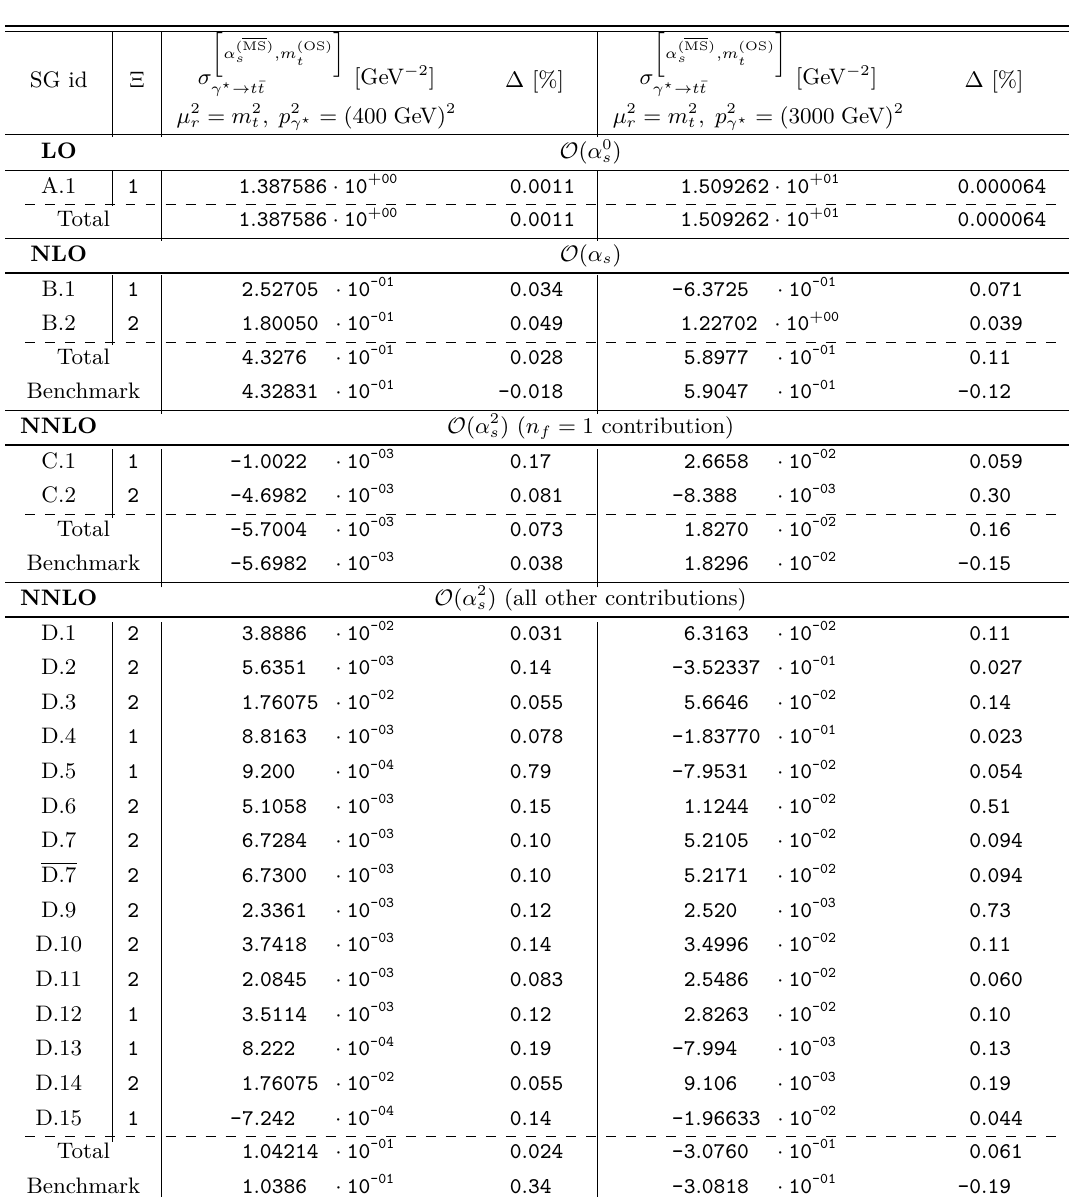
Table 3. Contributions from individual supergraphs listed in table 12 to the cross-section up to order O ( α 2 ) for the process γ ? → t ¯ t and two different energies p 2 s (360 GeV ) 2 . The strong coupling is renormalised in MS with µ 2 OS scheme. Ξ denotes the symmetry factor of the supergraph (included in the result reported). ∆ reports the relative Monte-Carlo error, except for the “Benchmark” entry [107, 108] where it refers to the relative difference w.r.t. the LU result